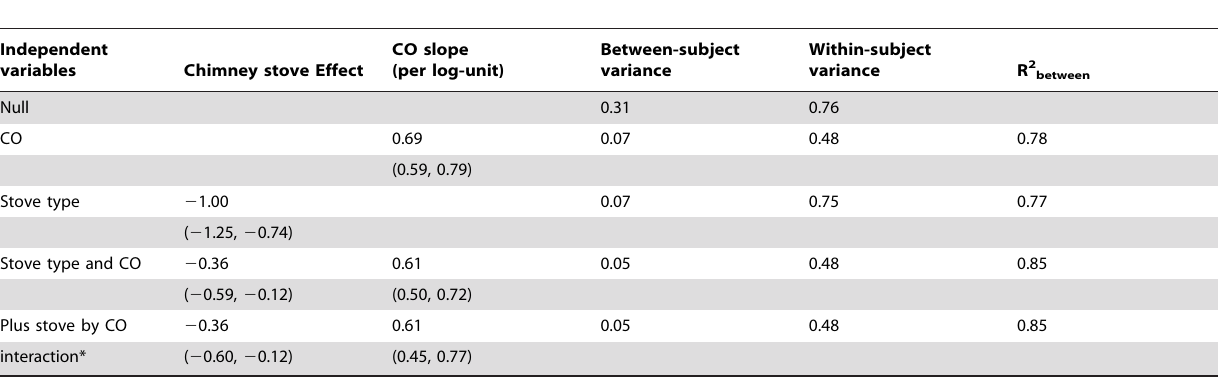
Table 1. Effect estimates (95% confidence intervals) and variance components from linear mixed effects models to predict natural log personal PM 2.5 (216 24-hour exposure measures among 116